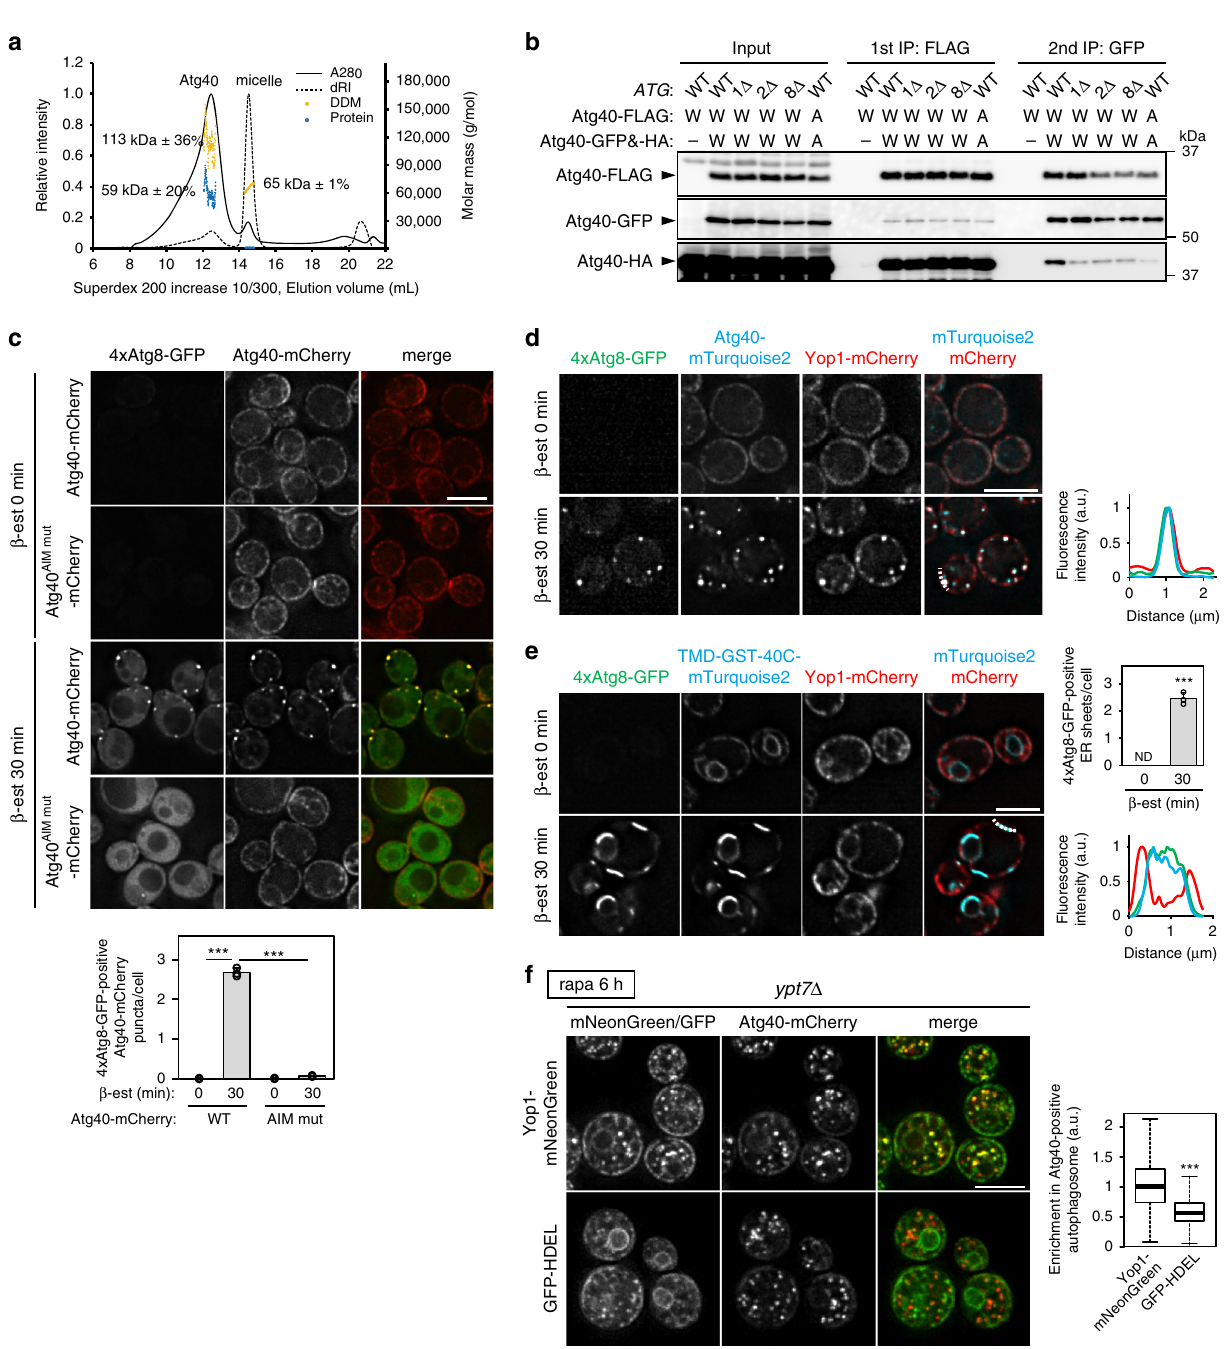
Fig. 4 Super-assembly of Atg40 generates ER membrane condensates with highly curved regions. a Puri fi ed Atg40-6His (30.6 kDa) solubilized in n- dodecyl- β - D -maltoside (DDM) was subjected to SEC-MALS analysis (see “ Methods ” ). dRI differential refractive index. b Cells coexpressing Atg40-FLAG, Atg40-GFP, and Atg40-HA under the ATG40 promoter were treated with rapamycin for 6 h, and cell lysates (input) were subjected to immunoprecipitation using anti-FLAG antibody-conjugated beads. Bound proteins were eluted with the FLAG peptide, and the eluates were subjected to a second immunoprecipitation using anti-GFP antibody. W, wild-type Atg40; A, the AIM mutant of Atg40. The experiments were performed independently three times. c Cells constitutively expressing Atg40-mCherry under the ADH promoter were treated with β -estradiol to induce expression of GFP-fused, tandemly repeated Atg8 G116A (4 × Atg8-GFP), and analyzed by fl uorescence microscopy. The quanti fi cation results are shown as means ± s.d. ( n = 3). d , e Assembly of Atg40-mTurquoise2 ( c ) or TMD-GST-40C-mTurquoise2 ( d ) was induced by expressing 4×Atg8-GFP. Enrichment of Yop1-mCherry in the assemblies was analyzed by fl uorescence microscopy. Line scan analysis of dashed line shows the normalized fl uorescence intensity. The quanti fi cation results are shown as means± s.d. ( n = 3). f Enrichment of Yop1-mNeonGreen and GFP-HDEL in Atg40-positive autophagosomes was analyzed by fl uorescence microscopy. The images are maximum-intensity projections of Z stacks (11 plane stacks, 0.2- μ m spacing). Box plots (center line, median; box limits, upper and lower quartiles; whiskers, 1.5 × interquartile range) show Yop1-mNeonGreen/GFP-HDEL signals in those autophagosomes against the entire signals (see “ Methods ” ). *** P = 1.68 × 10 − 6 ( c , WT 0 min vs WT 30 min), *** P = 1.91 × 10 − 6 ( c , WT 30 min vs AIM mut 30 min), *** P = 4.58 × 10 − 5 ( e ) (unpaired two-tailed Student ’ s t test); *** P = 2.2 × 10 − 16 ( f ) (unpaired two-tailed Mann – Whitney U test). Scale bars, 5 μ